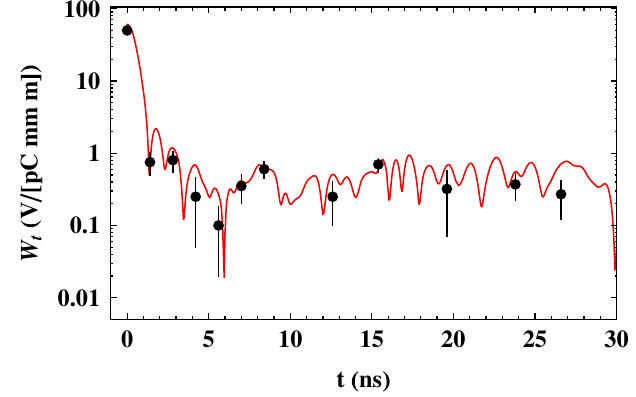
FIG. 13. (Color) Envelope of wakefield for H60VG4SL17A/B [37]. The wake predicted with the circuit model is indicated with the solid red line and the experimentally determined values by